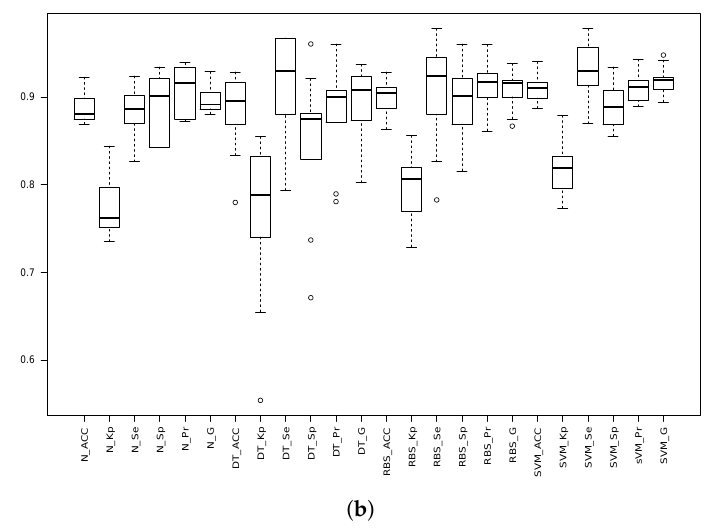
Figure 9. Box plots of the different statistics for the three models when the threshold is set to 3.0 × g (upper part) and 3.09290 × g (lower part) with the 5 × 2 cv. The prefixes N_, SVM_, DT_ and RBS_ stand for the NN, SVM, Decision Trees C5.0 and Rule-Based System C5.0 models. The statistics are: Accuracy (Acc), Kappa factor (Kp), Sensitivity (Se), Specificity (Sp), Precision (Pr) and the geometric mean (G), all of them computed using Equations (1) to (8). ( a ) th = 3.0 × g . ( b ) th = 3.09290 × g